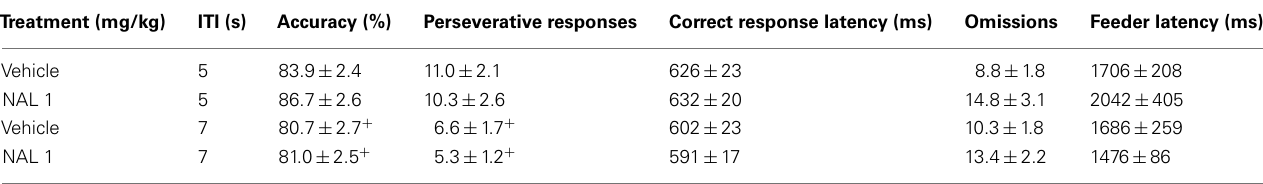
In total n = 16 rats were included in the analyses, and data depict mean ± SEM. + p < 0.05 versus respective ITI = 5s